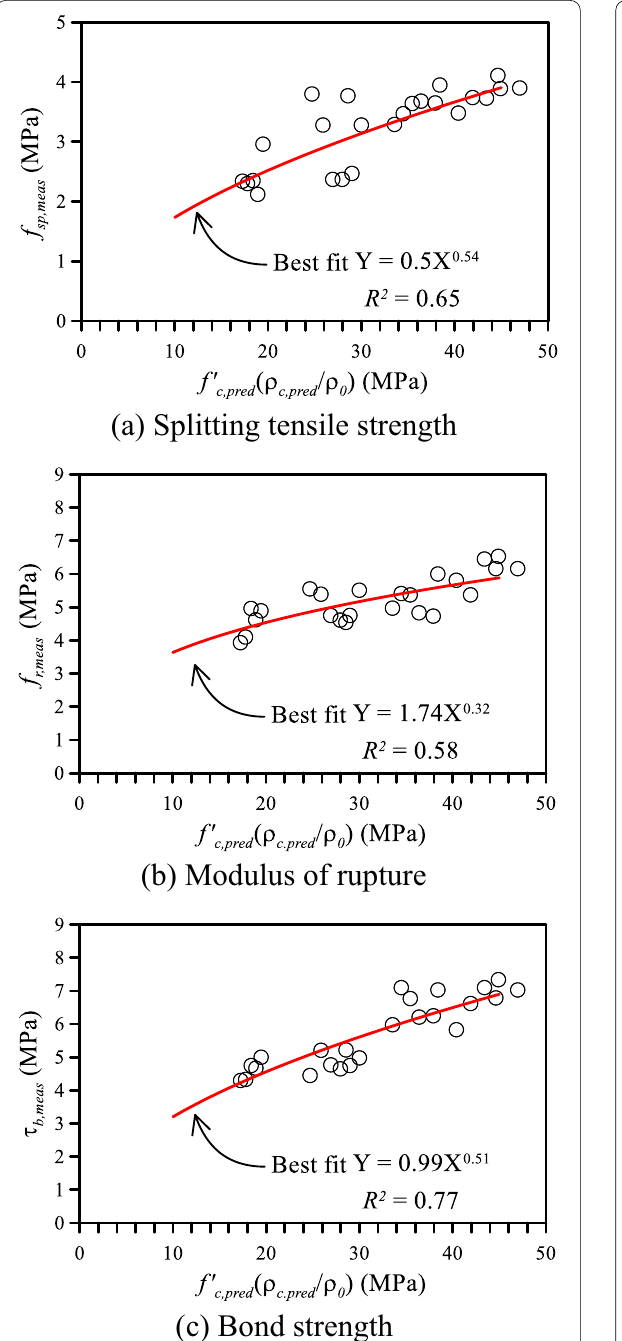
Fig. 11 Comparison of test results and prediction